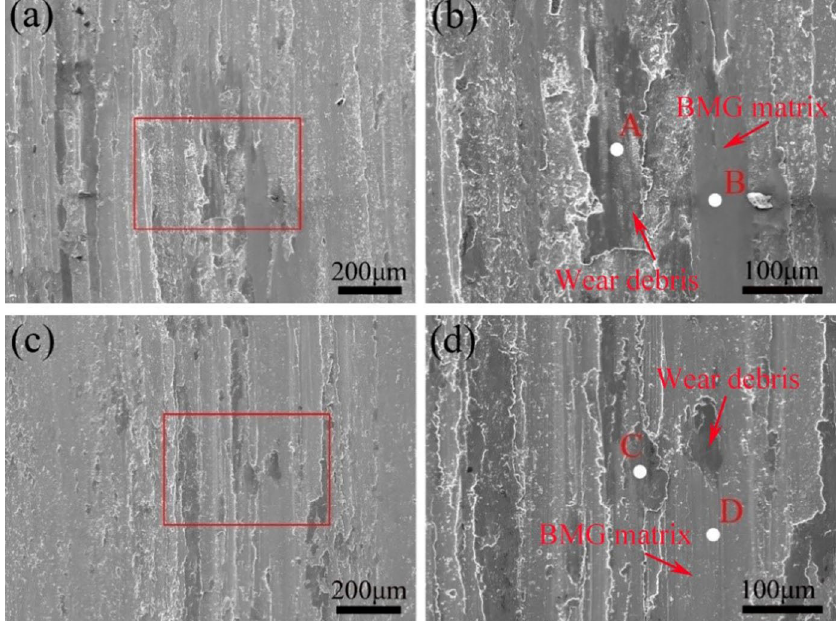
Figure 6. ( a , c ) SEM images of worn scars of as-cast and treated Zr 54.46 Al 9.9 Ni 4.95 Cu 29.7 Pd 0.99 BMGs tested in dry-sliding, respectively. ( b , d ) High-magnification detailed micrographs corresponding to the part marked by the red-lined rectangular in ( a , c ),